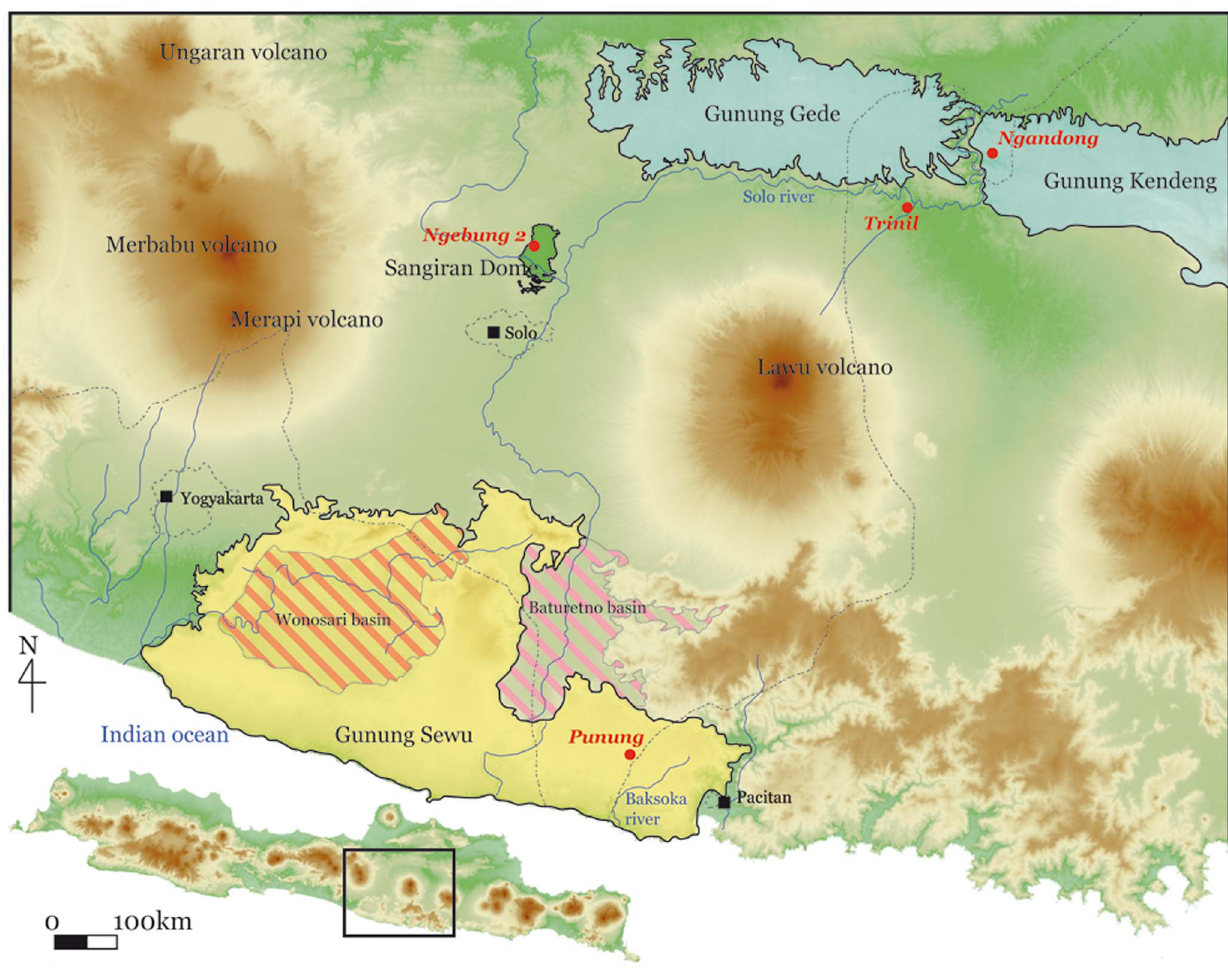
Figure 1. Map of Central Java pointing to the site of Trinil and other archaeological and paleontological sites mentioned in the text. This map was built up with GRASS open-source software from open access SRTM data [86] available from http://srtm.csi.cgiar.org.